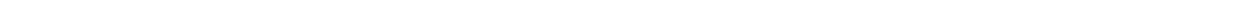
Fig. 4 A set of tissue-speci fi c or neuron-speci fi c RBPs regulate the timing of developmental splicing switches. a Dynamic expression of four families of tissue-speci fi c RBPs, including Ptbp1/2, Nova1/2, Rbfox1 – 3, and Mbnl1/2. RPKM values are normalized based on the maximum expression value in each family separately and shown in color scale. b Integrative modeling to de fi ne the target alternative exons regulated by each RBP family. The Venn diagram summarizes target exons regulated by each RBP family. Note 11 exons regulated by all four RBP families and an additional 58 exons regulated by three RBP families. c Regulation of WGCNA module exons by each of the four RBP families. Activation and repression of an exon by each RBP resulting from integrative modeling analysis are indicated in red and blue, respectively. The total number of regulators for each exon is shown in the bar on the right in gray scale (the darker, the more regulators). d – f Gabrg2 exon 9 as an example in module M1 under combinatorial regulation by all four RBP families. The exon inclusion level in developing cotex is shown in d and changes upon depletion of Ptbp2 (P0) and Mbnl1/2 (adult) are shown in e . Inclusion of the exon in wild type (WT) and mutant (MUT) splicing reporters, in combination with overexpression of different RBPs, is shown in ( f ). Rbfox-binding and Mbnl- binding site sequences are shaded. RBP expression and exon inclusion were measured by immunoblot and RT-PCR, respectively. g RBPs either antagonize (Ptbp2) or facilitate (Nova, Rbfox, and Mbnl) the mature splicing pattern through activation or repression of exon inclusion. h Time of the maximal splicing switch for target exons regulated by speci fi c RBPs (* p < 0.05, ** p < 0.001, t test). Only exons showing a more mature (for Ptbp) or embryonic (for Nova, Rbfox, and Mbnl) pattern upon RBP depletion were included for this anlaysis. i Prediction performance of exon module membership based on regulation by each RBP family. The performance is measured by partial area under curve (pAUC) of the receiver operating characteristic (ROC) plot with a cutoff at false-positive rate (FPR) ≤ 0.1. j Changes of predicted maturation stages of mouse brain tissues upon depletion of